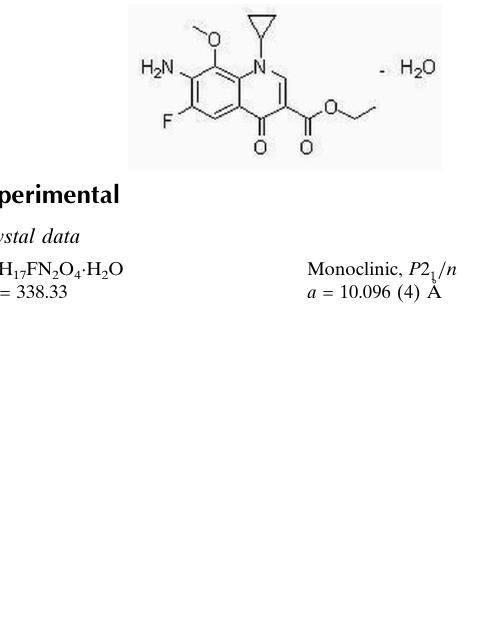
Related literature For general background, see: Fujita & Chiba (1998).